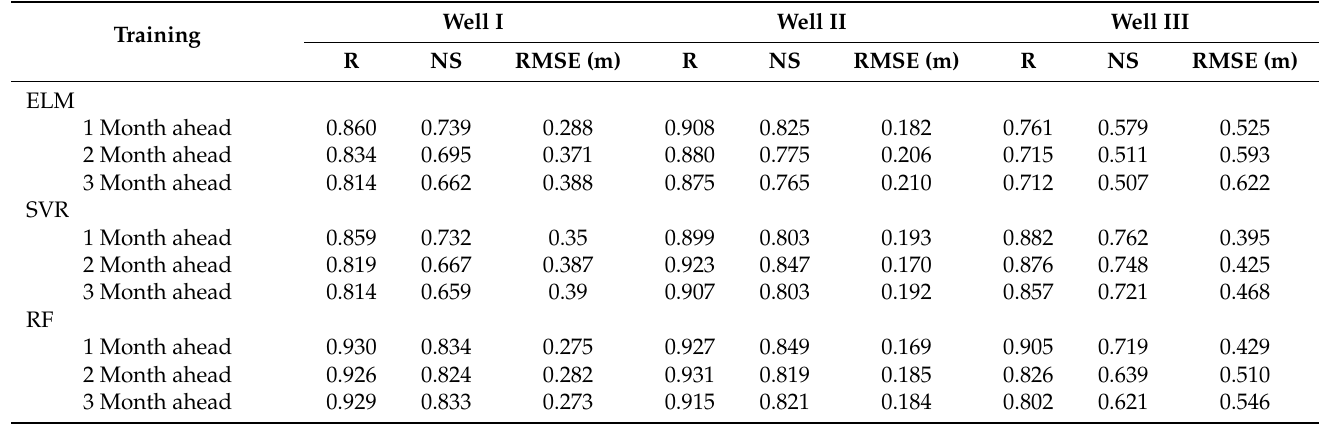
Table A2. Performance metrics of the standalone ELM, SVR, and RF models for 1-, 2-, and 3-month- ahead GWL prediction for Wells I, II, and III in the training periods.